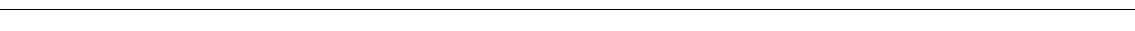
Figure 2 | Targeting of CUTie to cardiac myocyte subcellular sites. ( a ) Schematic representation of a portion of a cardiac myocyte in 2-D (left) and 3-D (right). In the panel on the right three myofibrils are shown, for two of which the sarcoplasmic reticulum (SR) surrounding individual myofibrils is depicted. The plasmalemma and its invaginations in T-tubules, which run along the Z-lines delimiting individual sarcomeres, are also shown. Colour shaded areas indicate the expected localization of targeted reporters. For clarity, only representative areas have been shaded. AKAP79-CUTie (green) is targeted to the surface of the plasmalemma facing the intracellular space; AKAP18 d (red) is targeted to the network SR surrounding individual myofibrils where SERCA also localize; TPNI-CUTie (yellow) localizes to the myofilaments constituting individual myofibrils, with exclusion of the Z-lines and the H zone. a -actinin localizes to the Z-line. Dimensions are from (ref. 54), 3-D schematic representation modified from (ref. 55). ( b ) Confocal images of ARVM expressing TPNI-CUTie, AKAP79-CUTie or AKAP18 d -CUTie showing the localization of the sensor relative to the localization of a -actinin, wheat germ agglutinine (WGA) and SERCA2, respectively. Scale bar: 10 m m. A merge of two images and a magnified detail for each cell are also shown. On the right, the fluorescence intensity profiles for the indicated targeted sensors (green) and the reference signal (red) are shown. Intensities were calculated along the line indicated in the zoomed-in images. ( c ) Western blotting analysis of proteins in complex with targeted CUTie. ARVM were infected with adenovirus carrying TPNI-CUTie, AKAP18 d -CUTie or AKAP79-CUTie. Targeted CUTie chimeras and their interacting proteins were pulled down using GFP beads. Membranes were probed with the antibodies indicated on the right of each panel. ( d ) Representative kinetics of sarcomere shortening recorded in ARVM expressing the targeted CUTie sensors in basal conditions (left) and on application of ISO 1nM (right). Representative of at least four biological replicates. ( e ) Representative kinetics of cAMP change recorded in NRVM microinfused with 1mM cAMP and 100 m M IBMX via a glass pipette (left panel) and mean maximal FRETchange ± s.e.m. at saturation for all measurements performed (right panel). N Z 10 from three biological replicates. No significant difference by one-way ANOVA and Bonferroni’s post hoc test. ( f ) Concentration–response calibration curves generated by microinfusion of known concentrations of cAMP in CHO cells stably expressing TPNI-CUTie, AKAP18 d -CUTie or AKAP79-CUTie. For each concentration point N Z